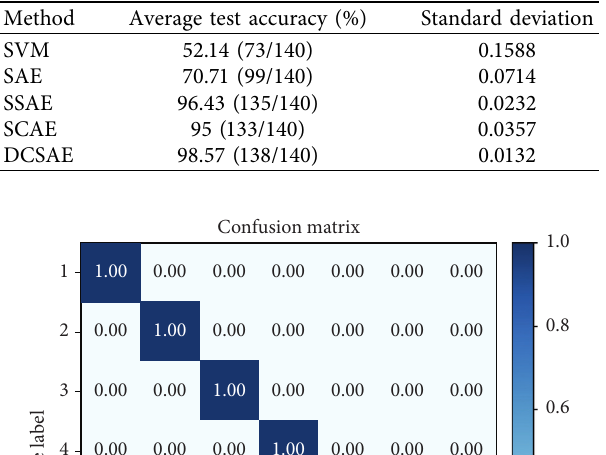
Figure 6: Comparison chart of different inputs for DCSAE. Table 4: Training time and average test accuracy of different inputs Table 5: Diagnosis results of five different methods. for DCSAE.